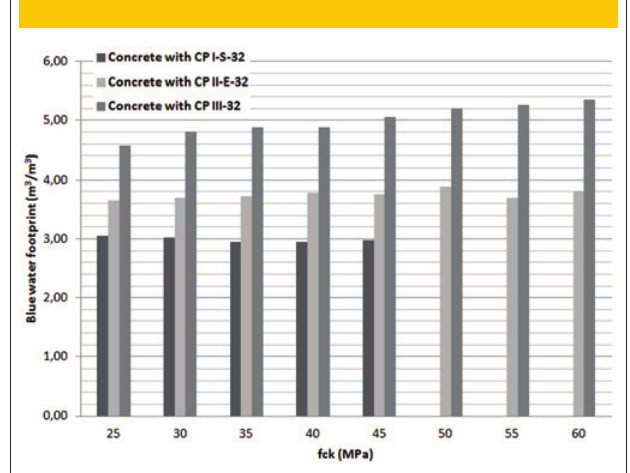
3 Figure 5 – Embodied energy calculated for 1 m of of concrete with CP I-S-32, CP II-E-32 and CP III-32